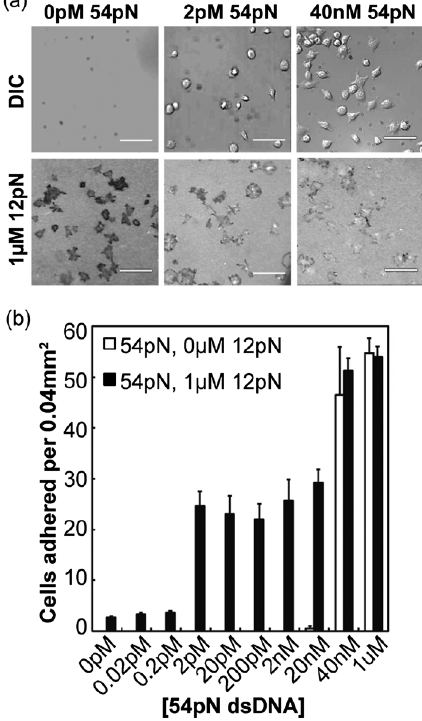
FIG. 4. Titration of strong TGT in multiplexing experiment. (a) Representative images of cells on different MP TGT surfaces. Differential interference contrast (DIC, top) and fluorescence loss of the weak TGT (bottom). Scale bars are 50 μ m. (b) Average density of adherent cells versus strong TGT incubation concen- tration. Only background levels of adhered cells are observed for concentrations lower than 40 nM of strong TGTs alone. However, when weak tethers are present, cells adhered for strong TGT concentration down to 2 pM but not at 0.2 pN. The cell density, although well above background levels, decreased for pM concentrations of the strong TGT. Error bars denote standard errors of